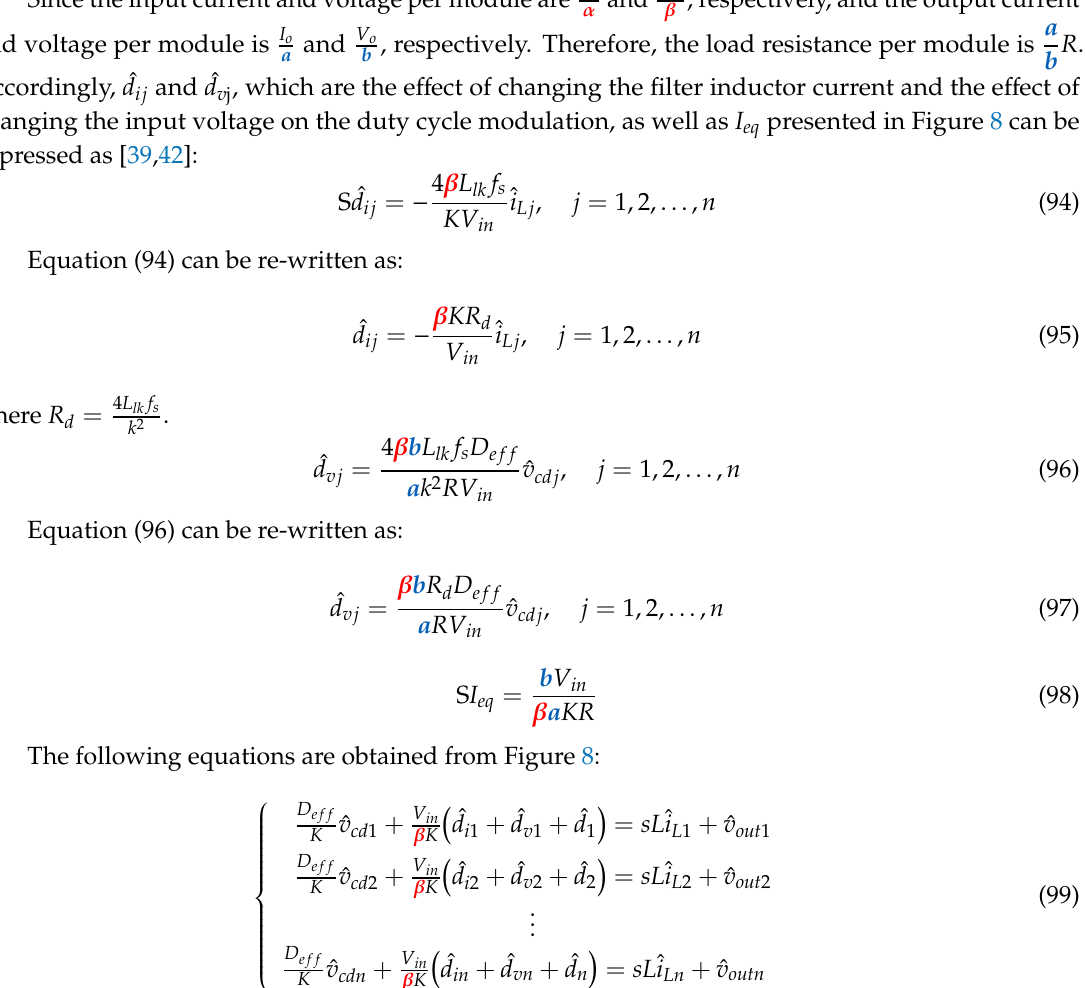
Figure 8. n module Input-Series Input-Parallel Output-Series Output-Parallel (ISIP-OSOP) DC-DC converter SSM.